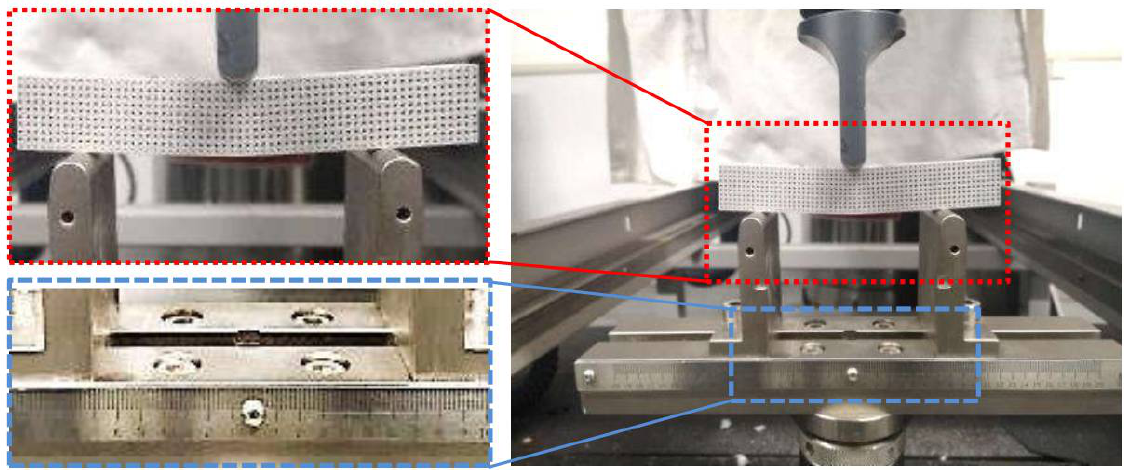
Figure 3. Three point bending device of SLM specimen.